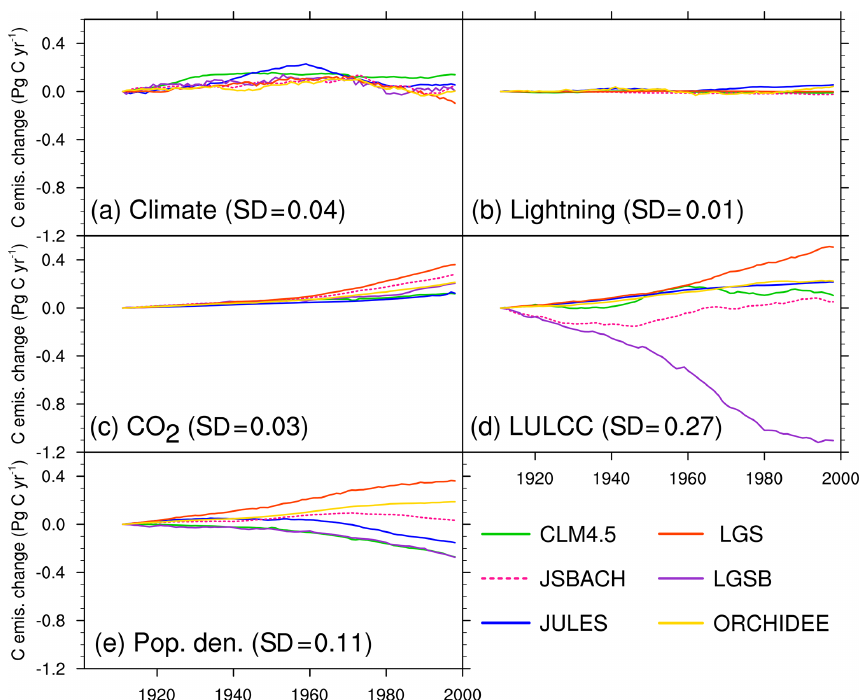
Figure 7. Change in global annual fire carbon emissions (PgCyr − 1 ) in the 20th century due to changes in (a) climate, (b) lightning frequency, (c) atmospheric CO 2 concentration, (d) land use and land cover change (LULCC), and (e) population density (control run–sensitivity run). A 21-year running mean is used. The standard deviations (SDs) of multi-model simulated long-term changes averaged over the 20th century are also given in parentheses. The control run is a normal transient run, and the five sensitivity runs are similar to the control run but without change in climate, lightning frequency, atmospheric CO 2 concentration, land cover, and population density, respectively. The 20th century changes in driving forces used in FireMIP are characterized by an increase in the global land temperature, precipitation, lightning frequency, atmospheric CO 2 concentration, and population density, expansion of croplands and pastures, and a decrease in the global forest